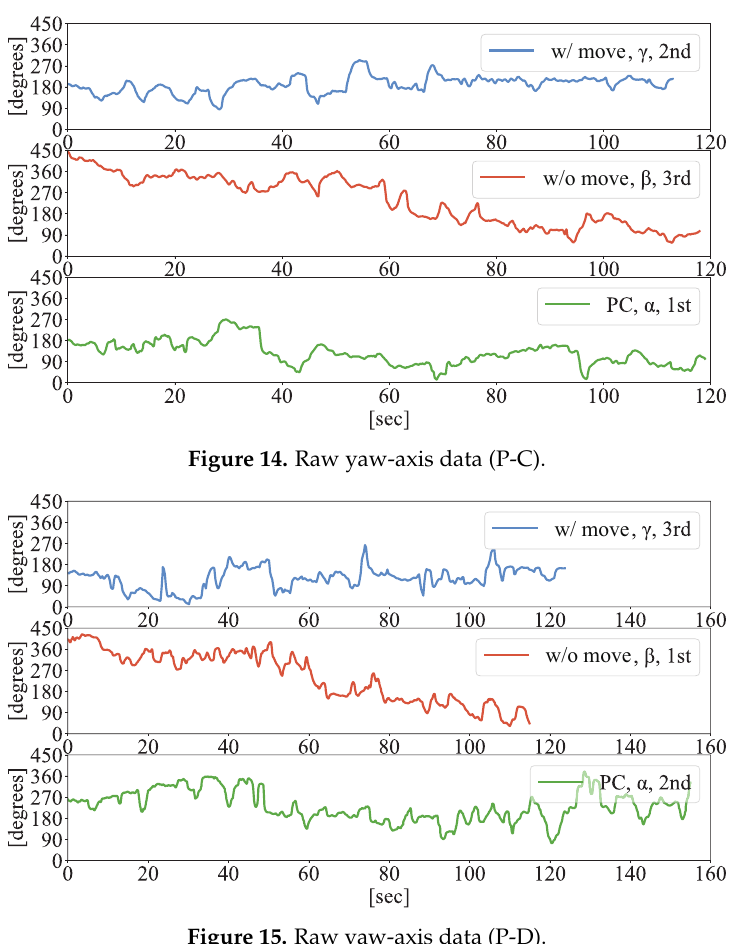
Figure 15. Raw yaw-axis data